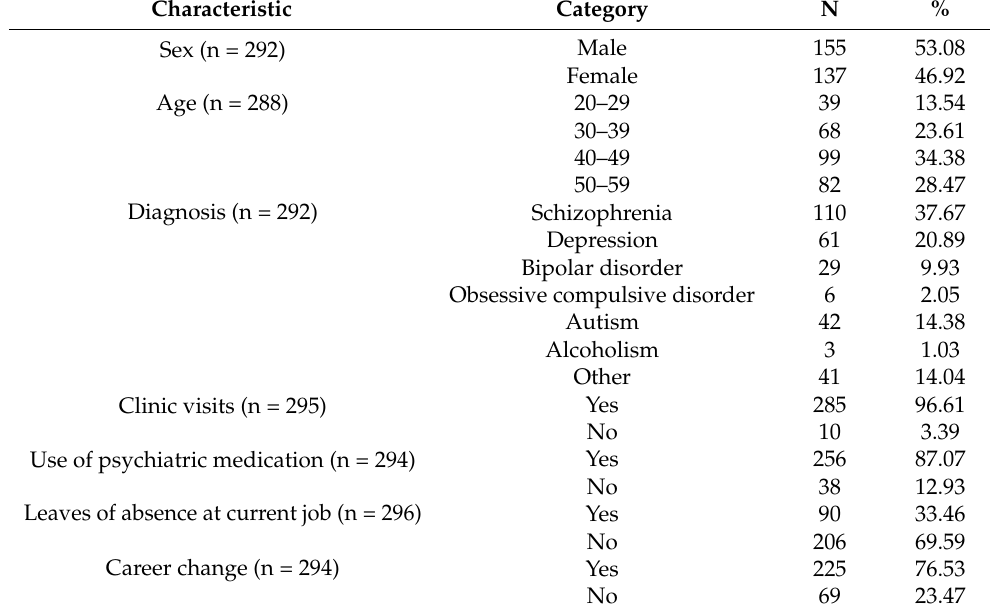
Table 2. Basic characteristics.